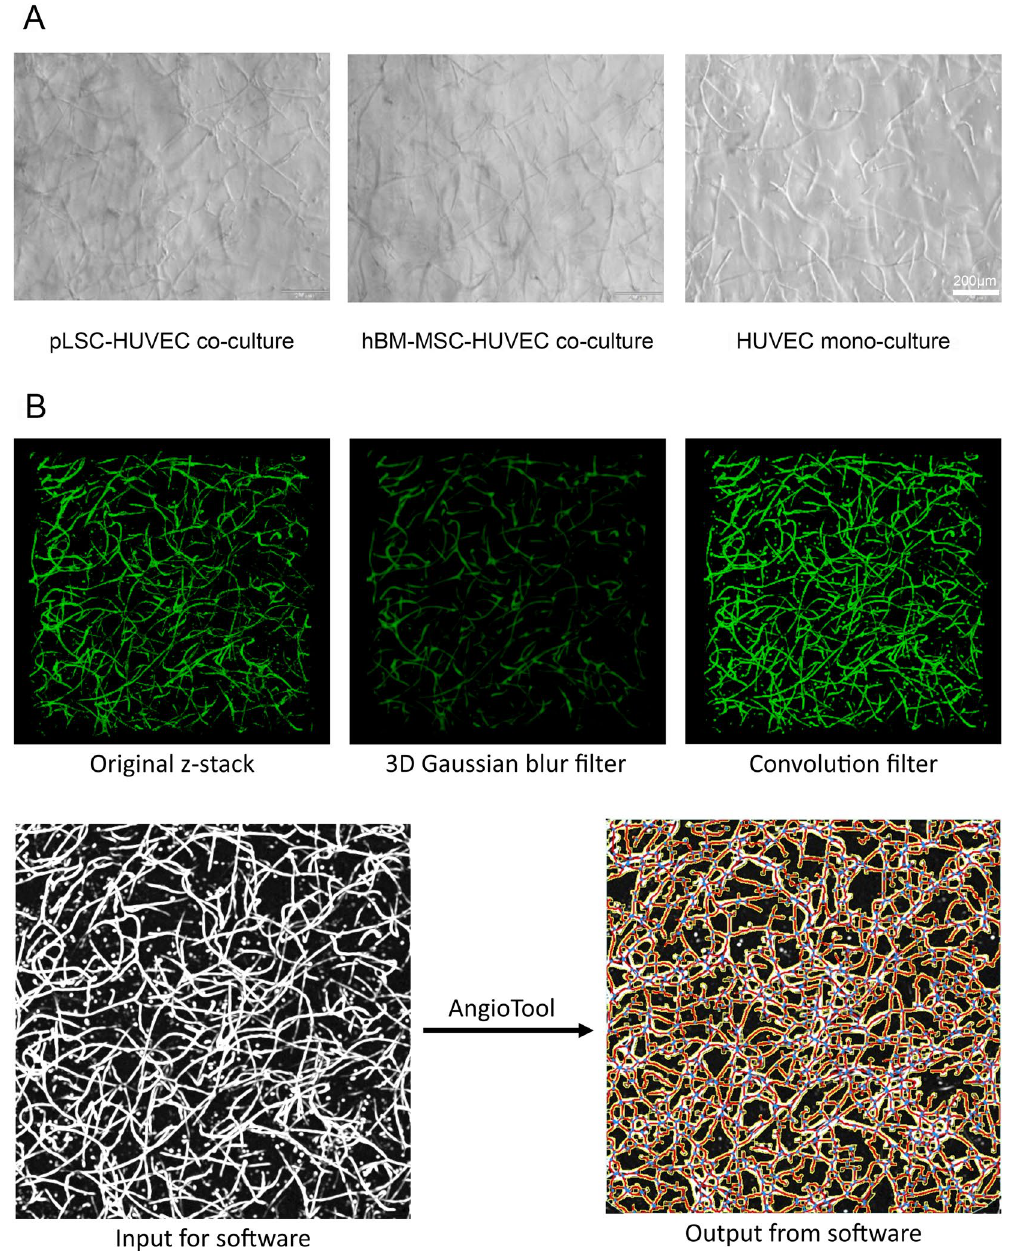
Figure 5. Analysis of pLSC-HUVEC network formation. Light microscope images of HUVEC co-cultures in starPEG-heparin hydrogels at day 7 ( A ). Scale bar = 200 μ m. Sequential steps in the quantification procedure of HUVEC network formation using Fiji (Image J) and AngioTool, exemplary images ( B